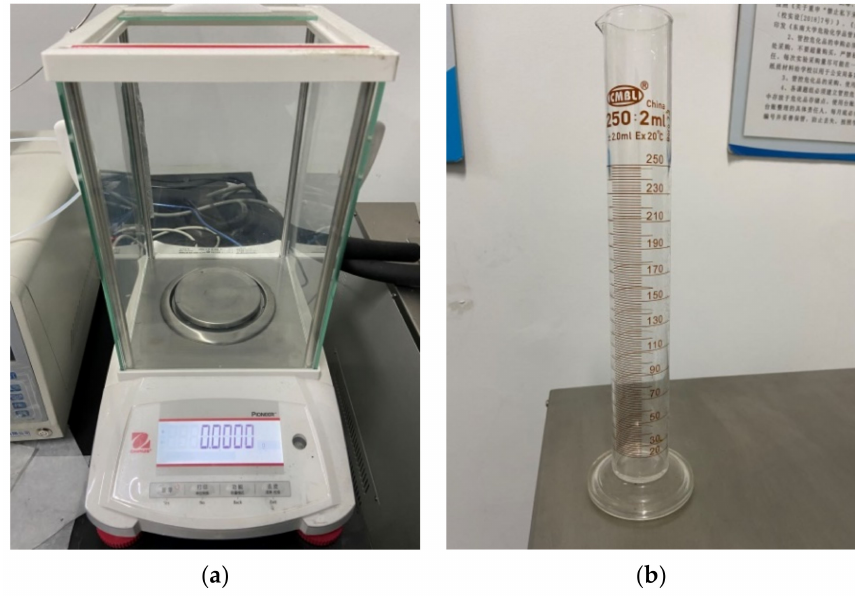
Figure 7. The apparatuses for testing density of rocks: ( a ) AUW320 dual-range semi-micro balance; ( b ) graduated cylinder.